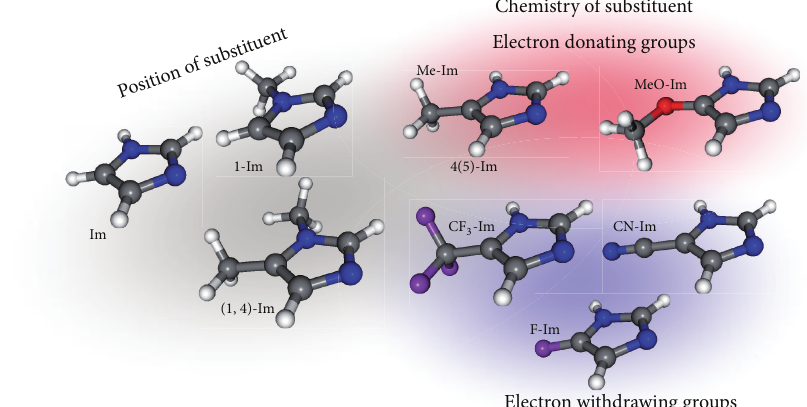
Scheme 10: Imidazole derivatives with various substituents at different ring positions. The molecules have been geometry-optimized using DFT [38].